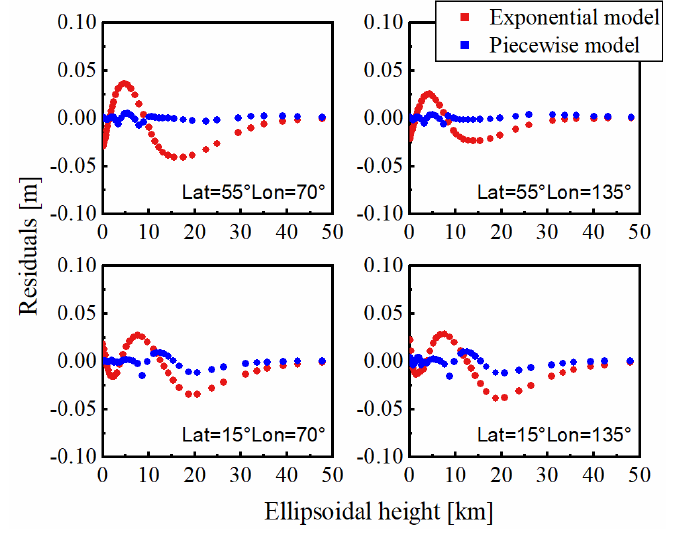
Figure 3. Fitting residuals of the exponential model and the piecewise model at different grid points.